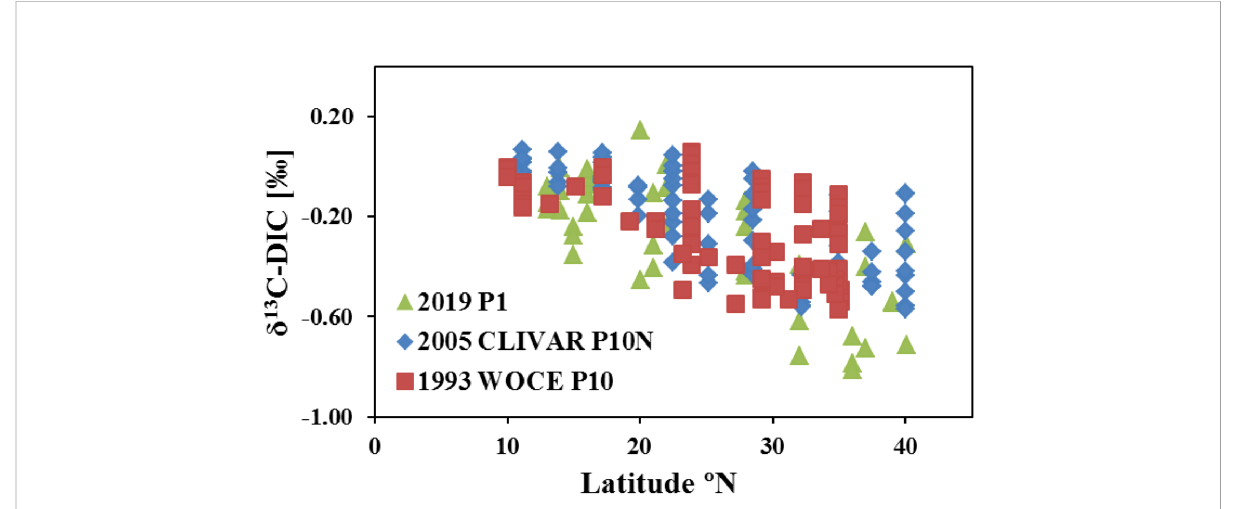
FIGURE 8 The d 13 C-DIC values for samples between 1,000 and 3,000 m depths as a function of latitude (10°N – 40°N) from 1993, 2005 and 2019.